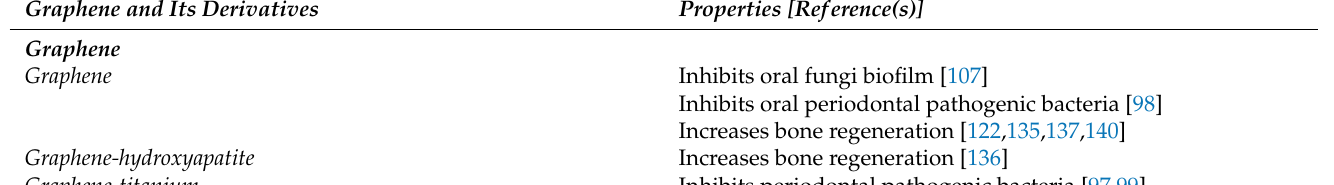
Table 2. Graphene and its derivatives for the management of periodontal